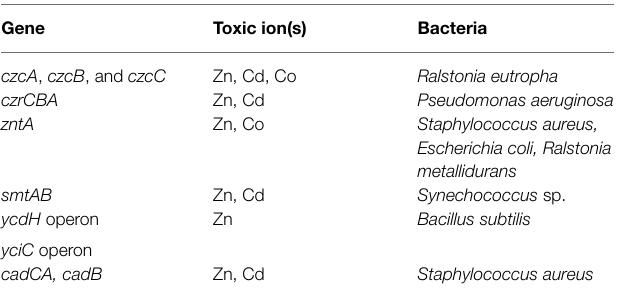
TABLE 2 | Genes involved in Zn resistance in Gram-positive and Gram-negative bacterial